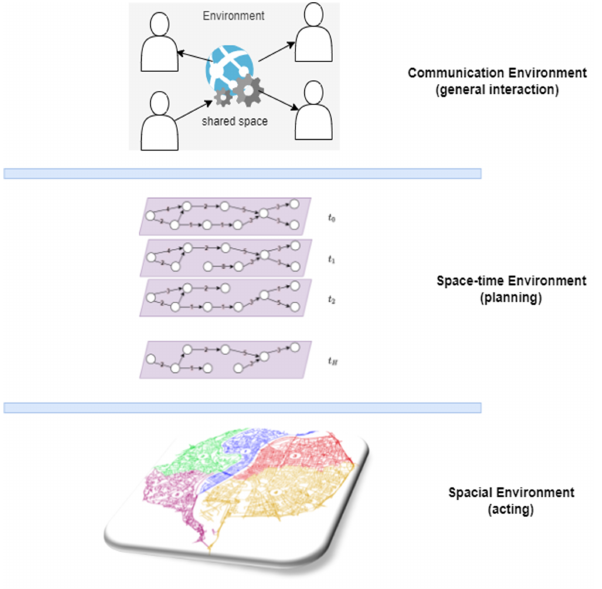
Figure 1. Layers of multi-agent